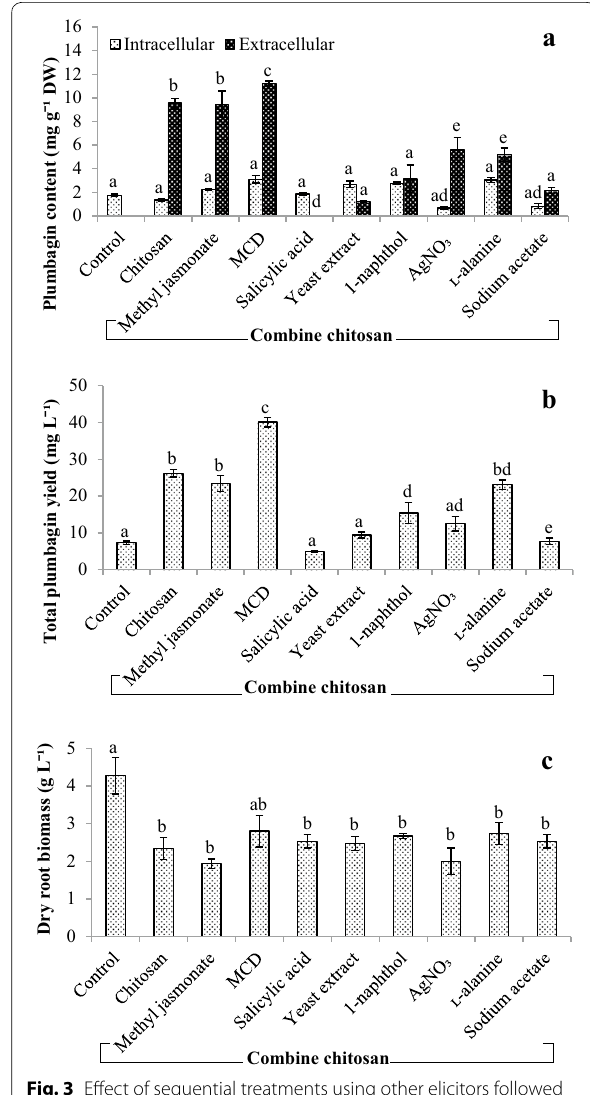
Fig. 3 Effect of sequential treatments using other elicitors followed by chitosan on a plumbagin content; b total plumbagin yield; c dry root biomass. Twelve-day P. indica root cultures were treated with methyl jasmonate, salicylic acid, 1-naphthol, yeast extract, MCD, AgNO 3 , sodium acetate and ʟ -alanine, then followed by 150 mg L − 1 chitosan at 14 days. Control is untreated root cultures with equal amount of distilled water or 2% ethanol added. Chitosan is the singly treated at 14 days. Measurements were taken after SE 72 h treatment from day 14 treatments. Values are mean ± triplicate experiments. Data were analyzed by one-way ANOVA, using Tukey’s test for multiple comparison. Different superscripts letters between the groups are significantly different at p < 0.05.